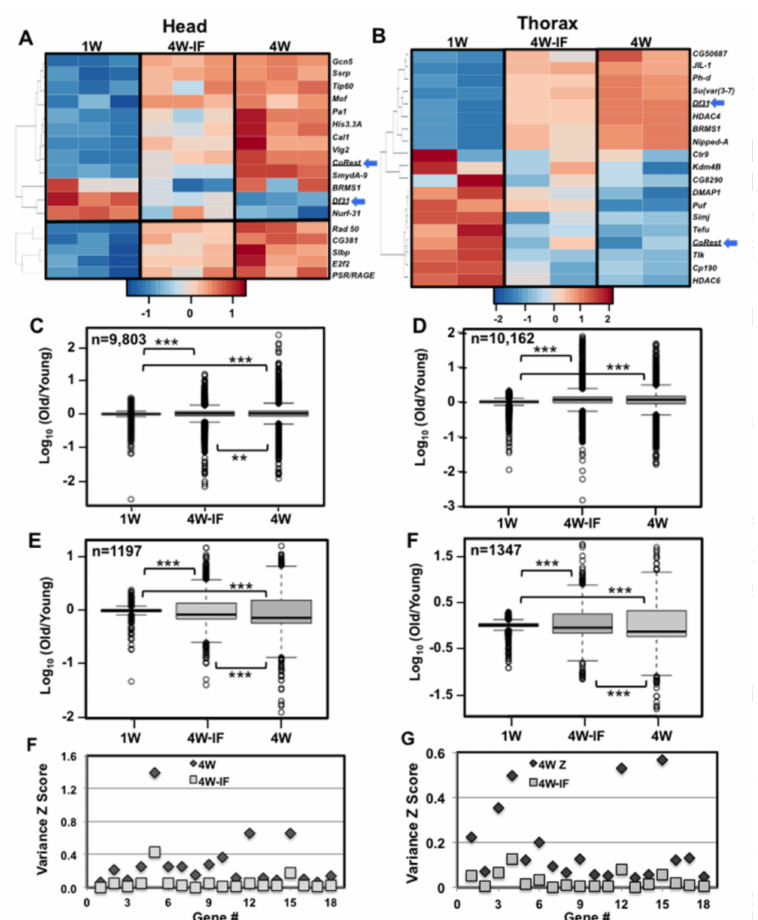
Figure 5. Age and IF-dependent changes to epigenetic pathway components and tissue specific transcriptional drift-variance profiles. Heatmaps of chromatin remodeling pathway components, showing dynamic FC to expression levels in aged ( A ) head or ( B ) thoracic tissue samples (n = number of genes). Arrows highlight the Df31 and CoRest transcripts (blue arrows) that have significant but opposing tissue specific FC to expression profiles. Representative drift-plots showing the global variance changes or VC (~10,000 genes) to ( C ) head or ( D ) thorax tissue transcriptomes, isolated from 1-week 1W, 4W to 4W-IF adult cohorts. Drift plots representing ( E ) head and ( F ) thoracic transcripts (~1200 genes) that showed significant age-dependent FC to expression levels. *** p ≤ 0.001. See Table 2 for additional details. DAVID analyses were used to determine the functional pathways of head and thoracic genes that demonstrated elevated variance Z scores (4W/4W-IF VC > 3.75). ( G ) The